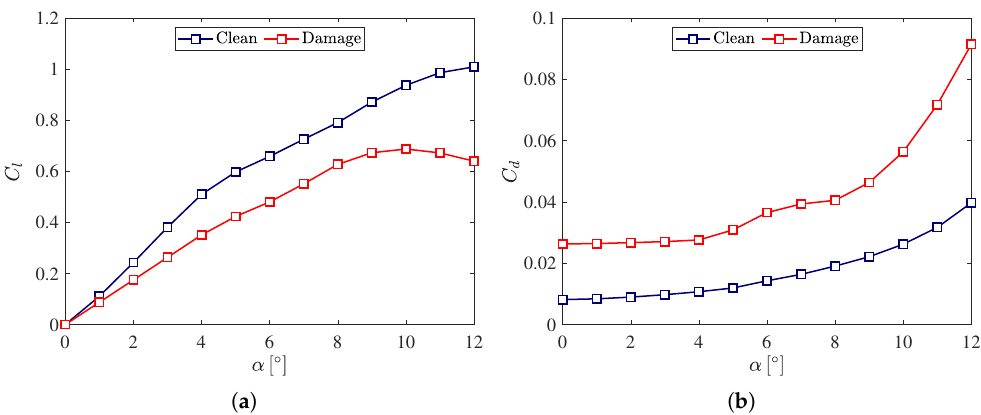
Figure 16. Comparison between polar diagrams of the clean airfoil and the damaged airfoil. ( a ) C l polar plot comparison; ( b ) C d polar plot comparison.